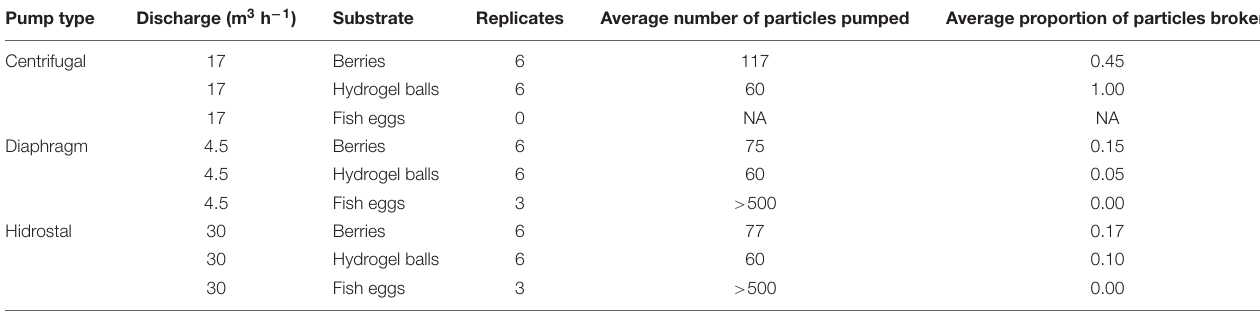
TABLE 2 | Summary of preliminary damage test outcomes using different pumps and substrates. Pump